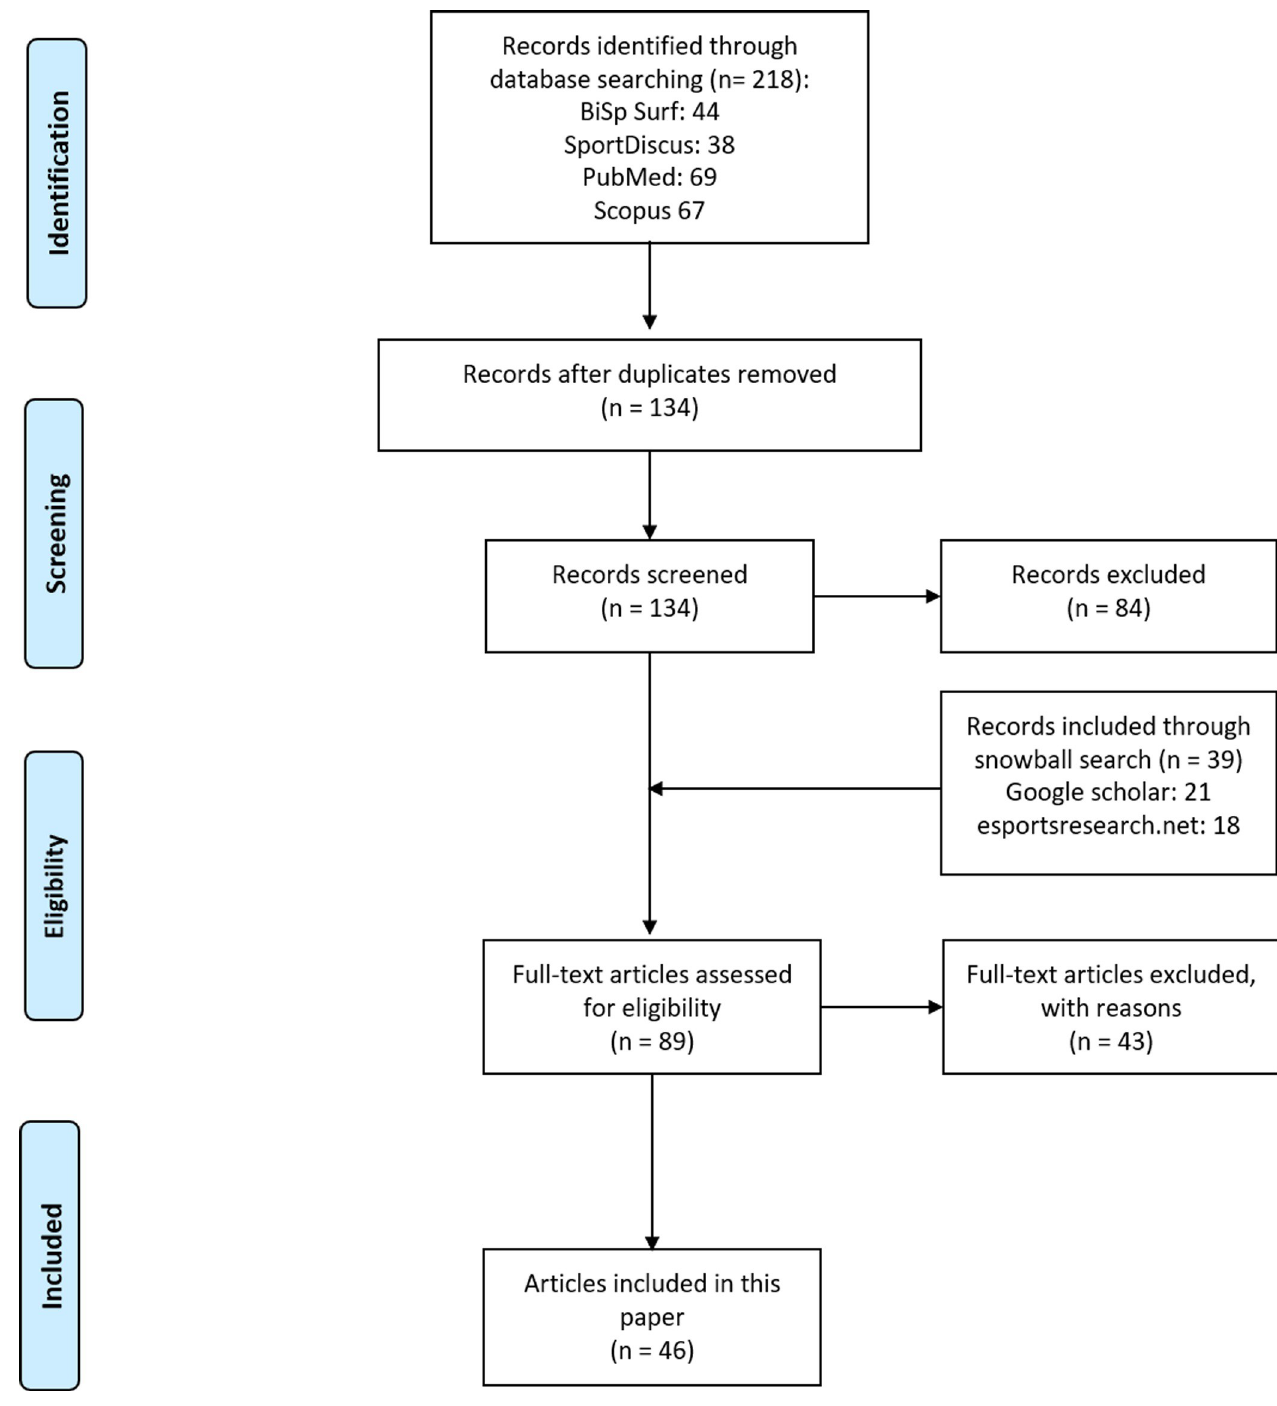
Fig 6. PRISMA-flow chart of systematic literature